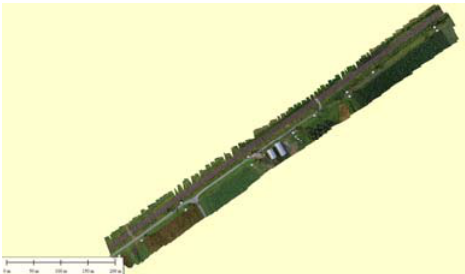
Figure 8: GCPs overlaid on orthophotos displayed in Global Mapper software Table 2: Single Strip ISO Accuracy Results - Railway Corridor